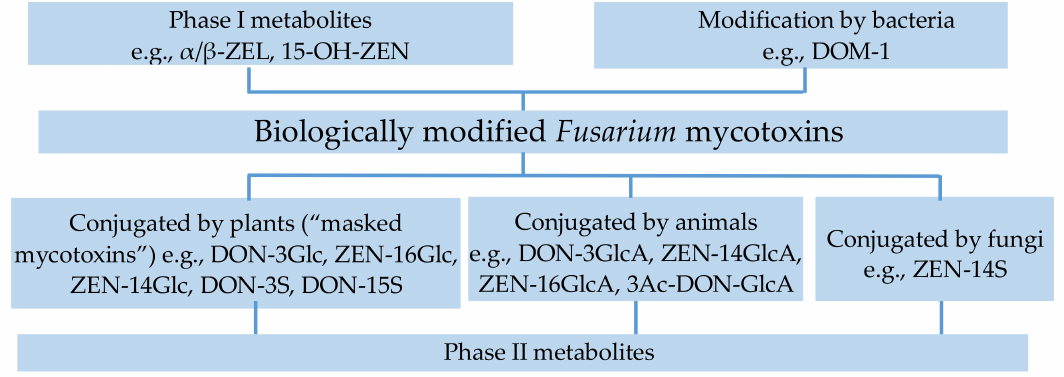
Figure 1. Taxonomy of biologically modified Fusarium